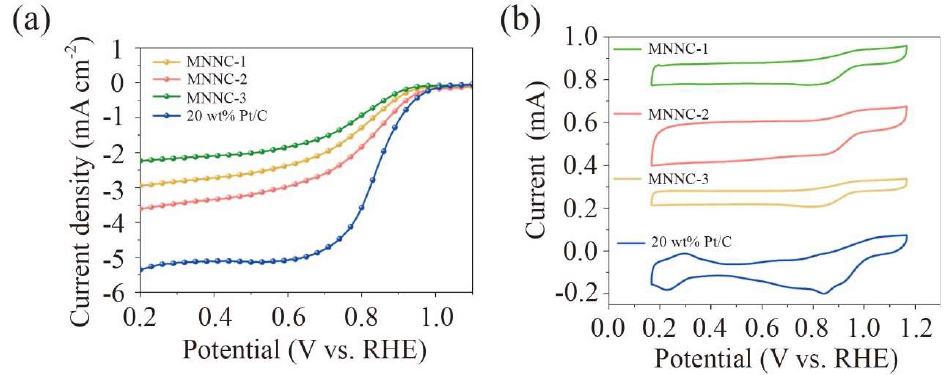
Figure 5. ( a ) RDE LSVs and ( b ) CVs of 20 wt.% Pt/C and MNNC-2 with different heating rates of 2 °C min −1 , 5 °C min −1 and 10 °C min −1 measured in O 2 -saturated 0.1 M KOH at a scan rate of 10 mV s −1 . The rotation speed for LSV test was 1600 rpm.